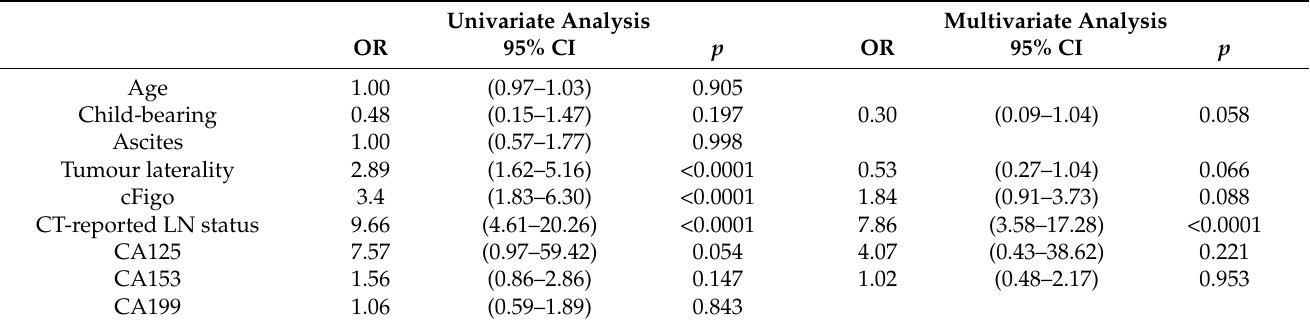
Table 2. Univariate and multivariate regression analyses of clinical factors associated with LNM in patients with epithelial ovarian cancer.